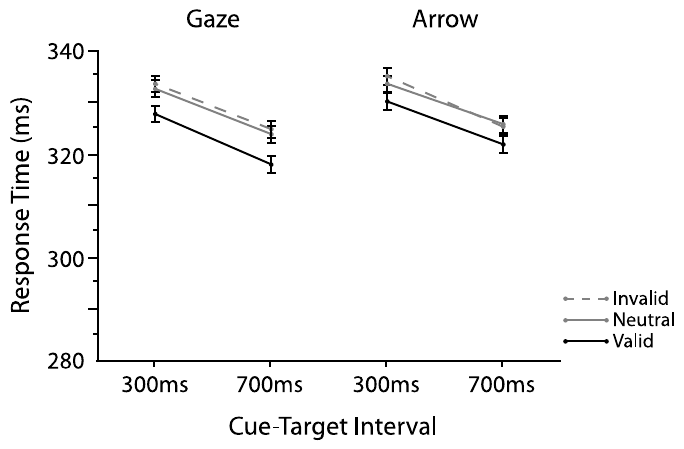
Figure 5. Mean RTs as a function of cue type, cue validity, and cue-target interval for Experiment 2. Error bars denote the standard error of the difference between the means.